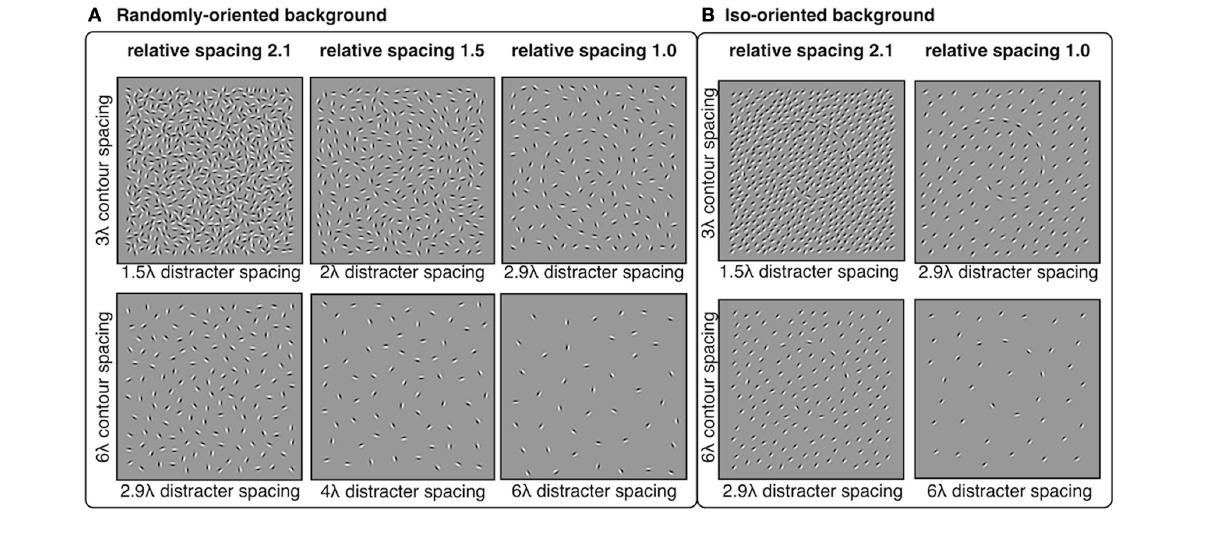
FIGURE 6 | Experiment 3 stimuli: spiral contours embedded in a background of randomly-oriented (A) or iso-oriented (B) Gabors with varying inter-element spacing. Contour elements had either 3 λ (top row) or